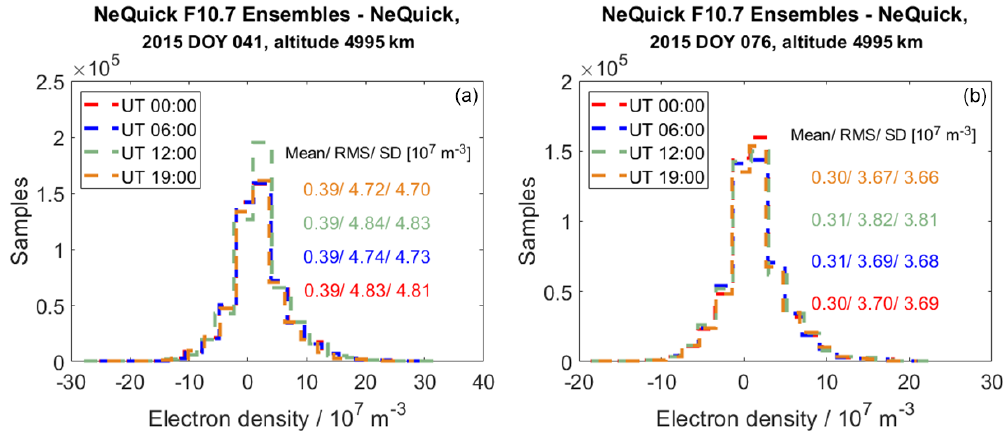
Figure 1. The distribution of the ensemble residuals for a chosen altitude and selected universal times (UTs), for all latitudes and longitudes, with panel (a) showing the day of the year (DOY) 041 and (b) showing DOY